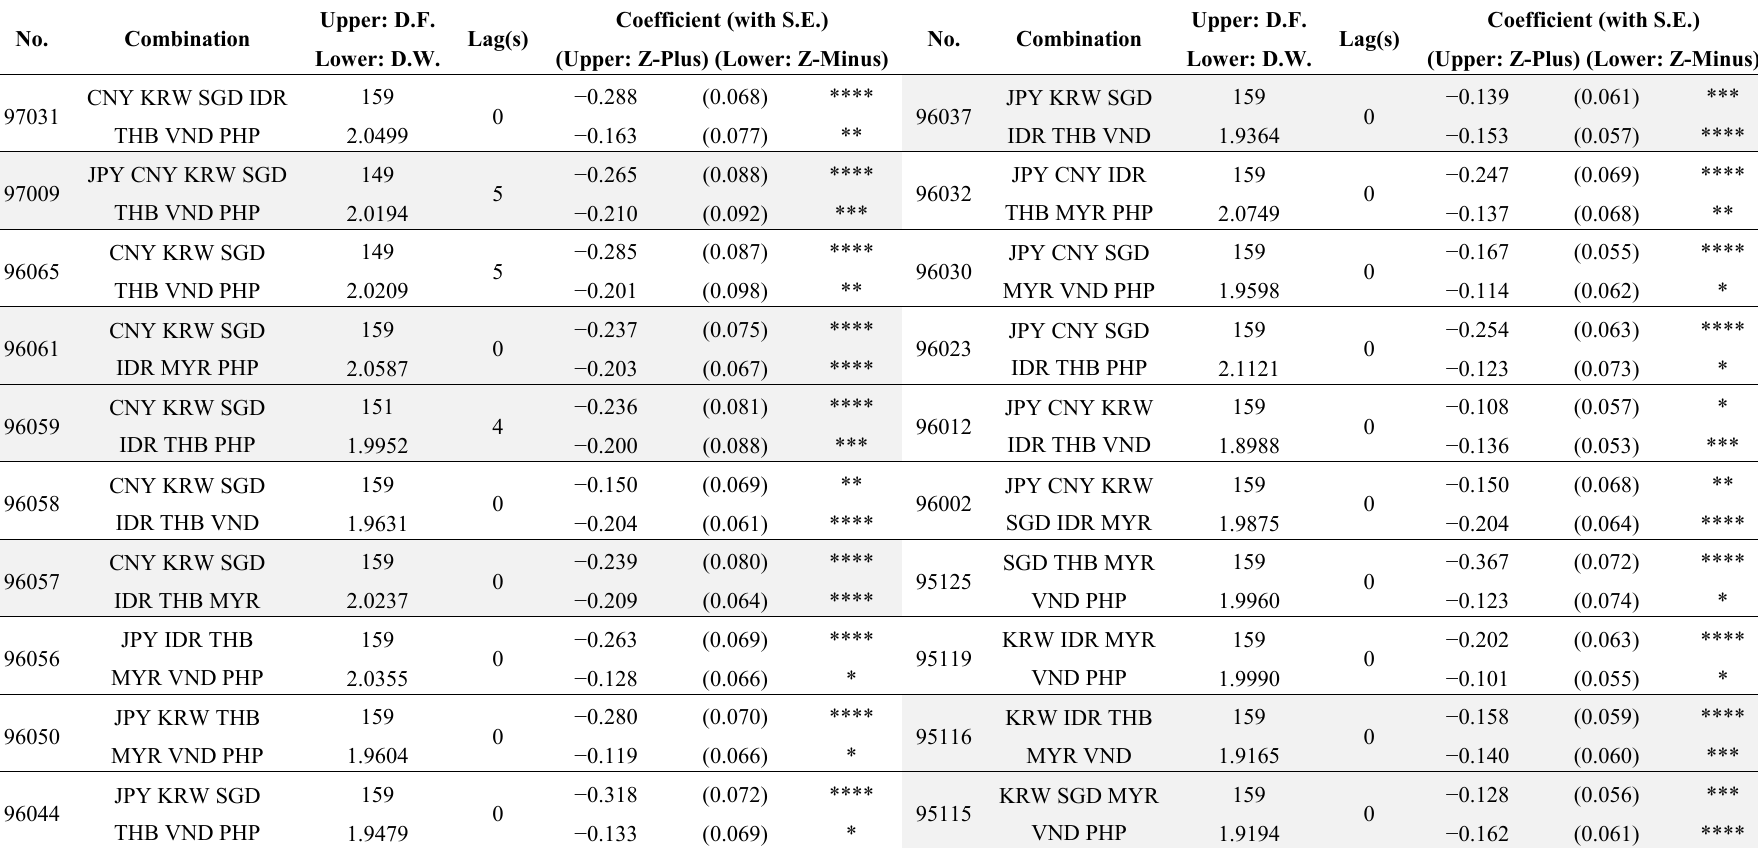
Table 2. M-TAR Unit Root Test for Residuals from Co-integration Estimation (January 2000–June